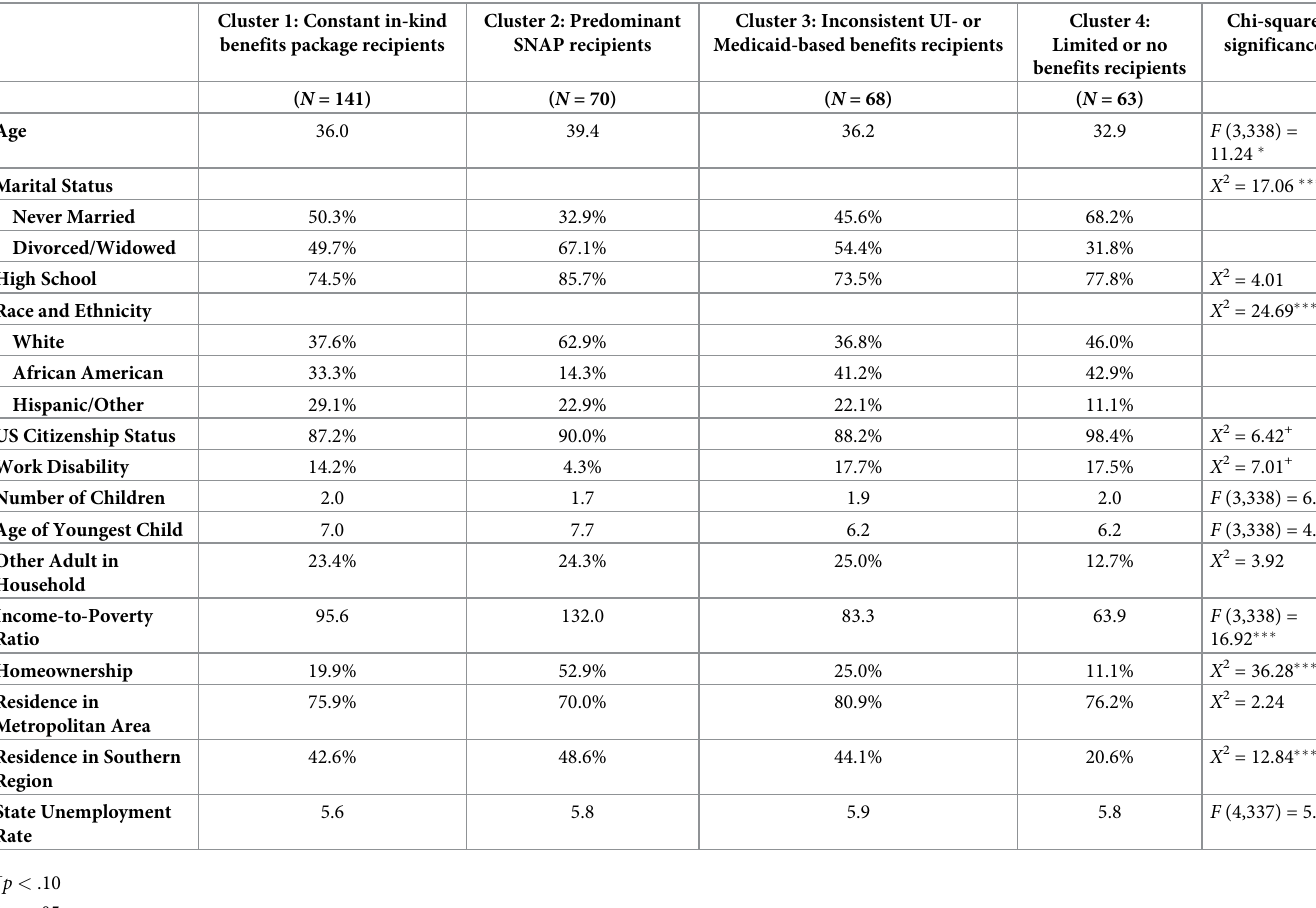
Table 2. Summary statistics of cluster